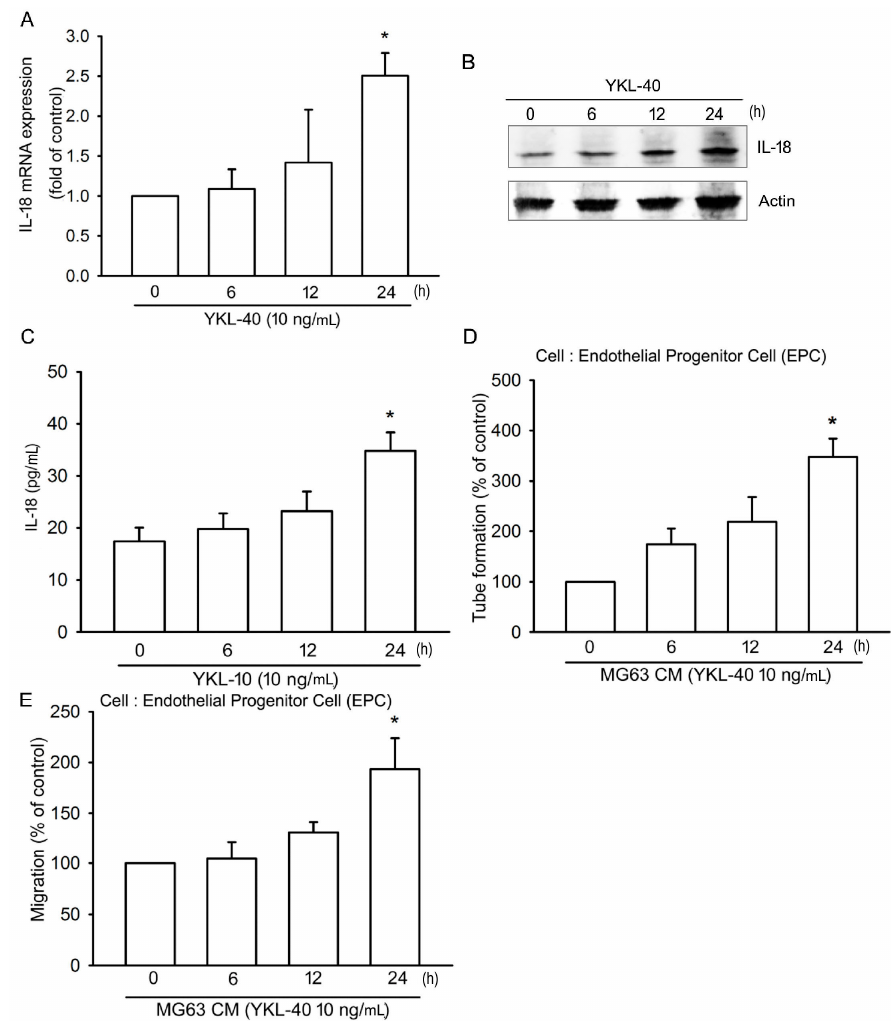
Figure 2. YKL-40 induces IL-18 production and EPC angiogenesis in a time-dependent manner. ( A – C ) MG-63 cells were treated with YKL-40 (10 ng/mL) for prespecified time intervals, as indicated.